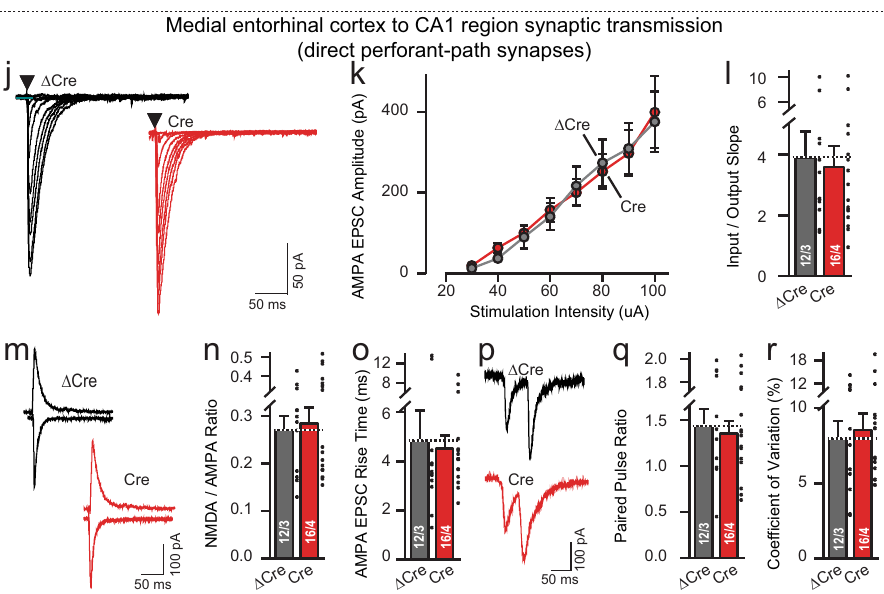
Fig. 8 Postsynaptic deletion of Tenm3 and Tenm4 in CA1 region neurons has no effect on MEC → CA1 or CA3 → CA1 synaptic transmission. Data are from patch-clamp whole-cell recordings in acute hippocampal slices from Tenm3 and Tenm4 DcKO mice at P19-22. The proximal CA1 neurons of mice were infected unilaterally with AAVs encoding EGFP-tagged Δ Cre (control) or Cre at P0. Deletion of Tenm3 and Tenm4 in CA1 neurons has no effect on the synaptic responses mediated by CA3 → CA1 Schaffer-collateral inputs ( a , representative traces showing Schaffer-collateral EPSC at increasing stimulus; b , input-output curves; c , summary graph of the slopes of the input-output curves). The Tenm3/4 double deletion in CA1 neurons does not alter the AMPAR/NMDAR ratio and AMPA EPSC rise time in Schaffer-collateral inputs compared to Δ Cre controls ( d , representative traces of AMPAR/NMDAR EPSC; e , summary graph of the AMPAR/NMDAR EPSC ratio; f , summary graph of the AMPA EPSC rise time). g – i Double deletion of Tenm3 and Tenm4 does not alter the paired-pulse ratios of Schaffer-collateral EPSC ( g , representative traces; h , summary graph of the paired-pulse ratios), or the coef fi cient of variation ( i , summary graph of the coef fi cient of variation). j – r , the same as a – i , except that the synaptic responses were analyzed by MEC → CA1 perforant-path inputs. Data are means ± SEM; numbers of sections/mice are indicated in the bars. Statistical signi fi cance was assessed using two-sided Student ’ s t-test (* p < 0.05; ** p < 0.01; *** p < 0.001). For additional experiments, see Supplementary Fig. measurements of the coef fi cient-of-variation demonstrated large increases in both parameters, consistent with a decrease in release probability in Tenm3/4-de fi cient synapses (Fig. 10f – i). Thus, the presynaptic Tenm3/4 deletion, different from the postsynaptic Tenm3/4 deletion, causes a major disruption of functional synaptic connectivity at MEC → CA1 synapses and additionally changed the properties of the remaining synapses.